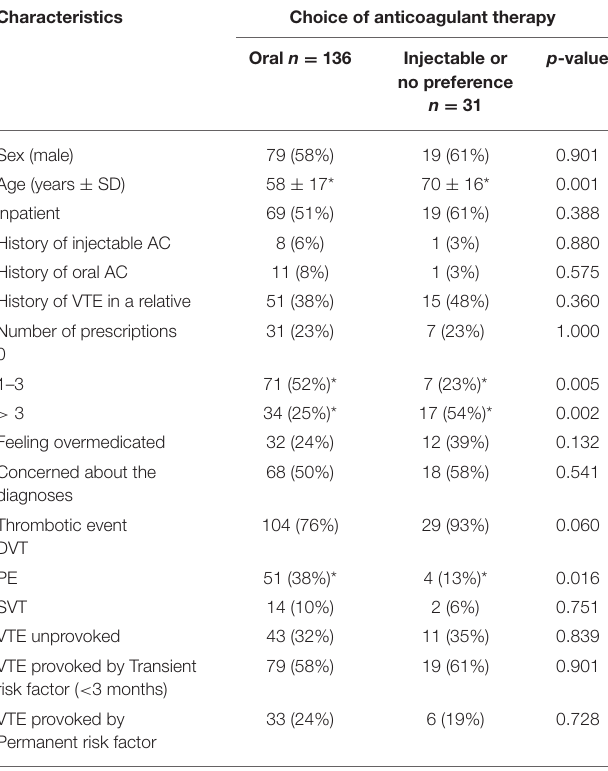
TABLE 3 | Influence of patient characteristics and thrombotic event in the choice of oral or injectable anticoagulant therapy.